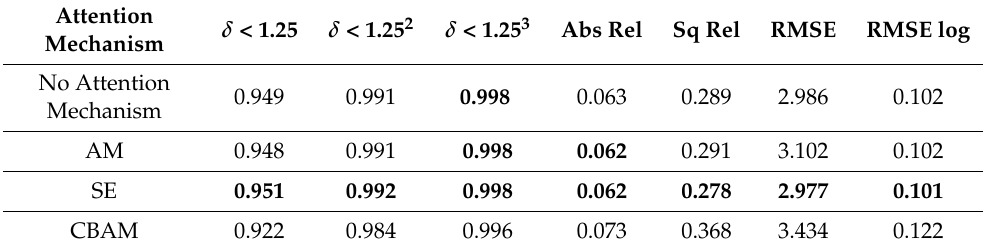
Table 1. The evaluation of our background depth prediction model using the different attention